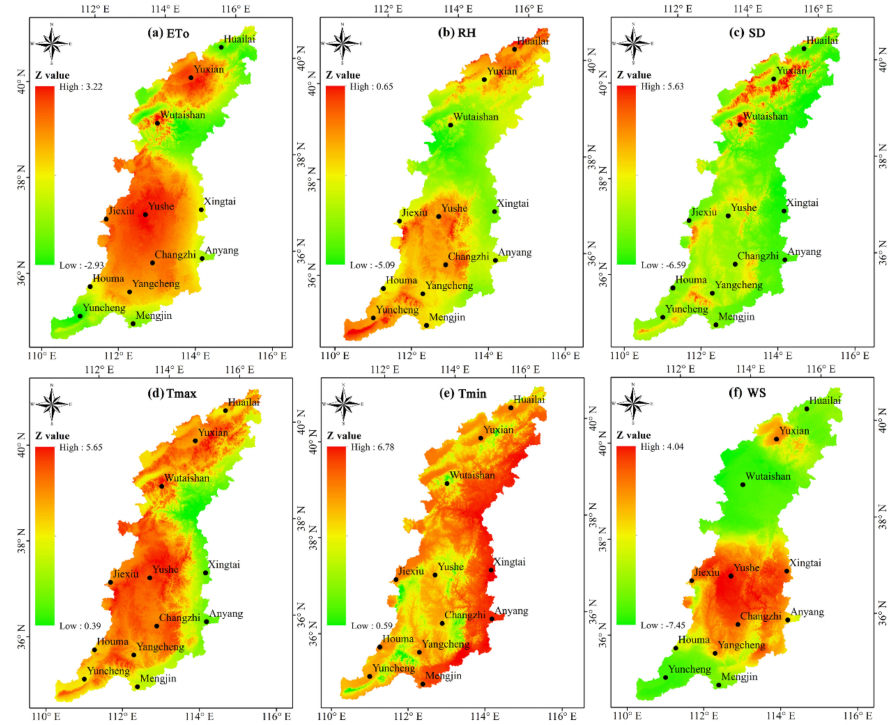
Figure 3. Z values of the TFPW MK trend test of ETo and climatic factors during 1973–2016. ( a ) ETo, ( b ) RH, ( c ) SD, ( d ) Tmax, ( e ) Tmin, ( f )